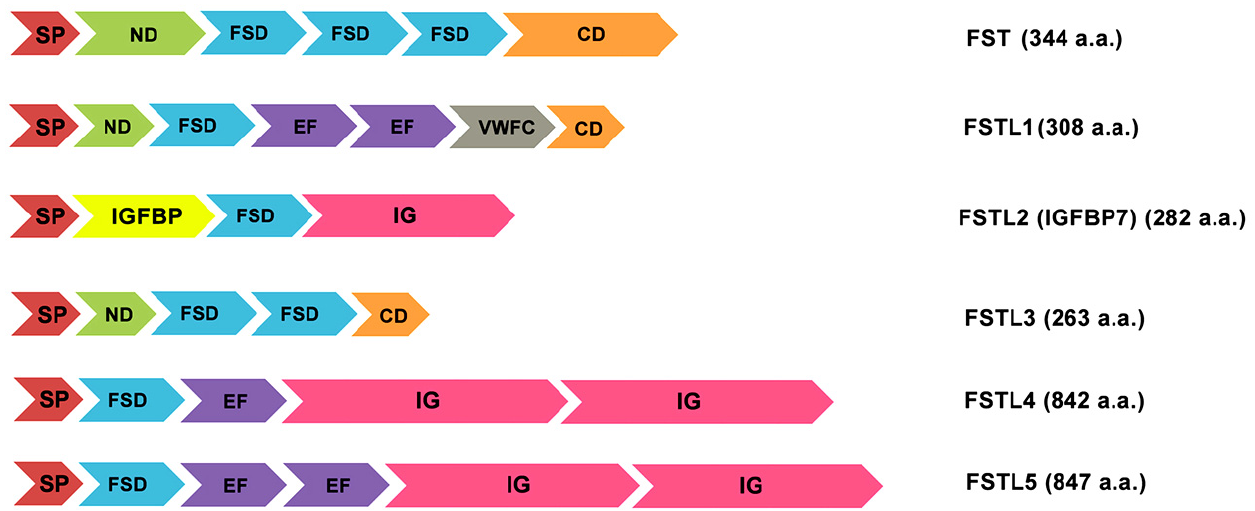
Figure 2. Variety of follistatin-like proteins and their domain organization. SP: signal peptide; ND: N-terminal domain; FSD: Follistatin/Kazal-like domain; EF: a helix-loop-helix structural domain; VWFC: von Willebrand factor type C domain; IGFBP: IGF-binding domain; Ig: immunoglobulin-like domain; CD: C-terminal domain with acidic L-amino acids. The text on the right shows the accepted name of the protein and the number of its constituent amino acids (a.a.) [1,2,30,44–47].